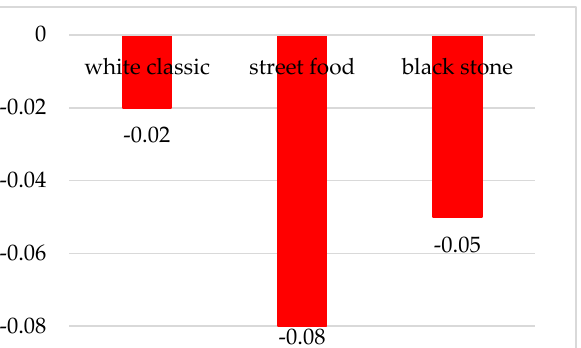
Figure 6. Thermal map of visual attention of waffles served in three different ways.